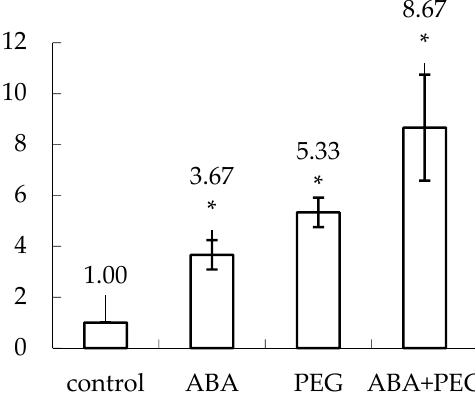
Figure 4. The rate of micropropagation of tobacco shoots (N. tabacum L., ‘Baladi’) clones originating from hypocotyls submitted to the effect of ABA (clones 1 and 2), PEG (clones 3–13), ABA & PEG (clones 14–17) and control (C) were monitored during three generation of cultivation in stage 2. It is obvious a stimulation of the multiplication rate of all plantlets that have been generated from stressed hypocotyls with ABA, PEG and ABA & PEG. * Significant differences: p < 0.05